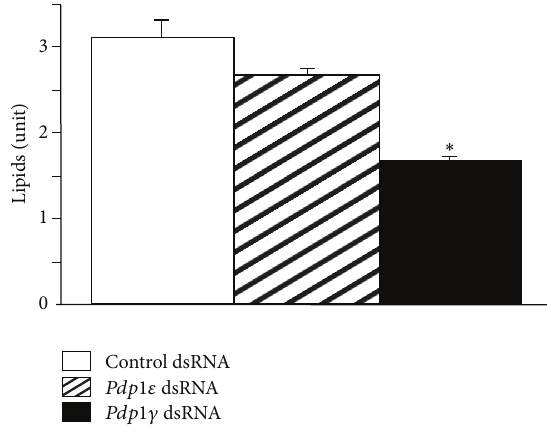
Figure 3: Quantitative assay of Drosophila lipid content following the isoform-specific Pdp1 RNAi. Adult flies were injected with control, Pdp1 𝛾 , and Pdp1 𝜀 dsRNA and processed for quantitative lipid assay. Pdp1 𝛾 but not Pdp1 𝜀 dsRNA reduced body lipid content ( ∗ 𝑃 < 0.001 versus control; 𝑛 = 5 ; mean ± standard error